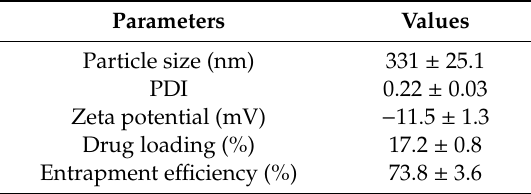
Figure 1. Characterization of DBCO-functionalized, PTX-loaded PLGA nanoparticles (DBCO-PTX NP). ( A ) Particle size distribution as determined by dynamic light scattering. ( B ) A representative TEM image of DBCO-PTX NP. Nanoparticles are shown with white arrows to differentiate from the comb-like mesh background. ( C ) In vitro release profile of PTX from DBCO-PTX NP in MSC complete growth medium supplemented with 10% (w/v) Captisol ® at 37 °C. Data shown is mean ± SD ( n = 4). Table 1. Mean particle size, PDI, zeta potential, drug loading, and entrapment efficiency of DBCO-PTX NP. Data shown is mean ± SD ( n = 6).